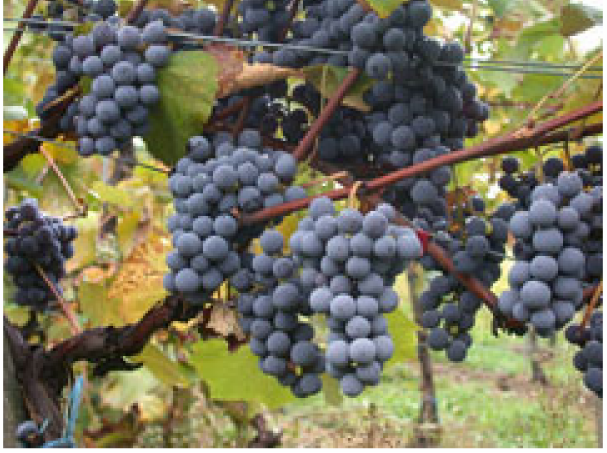
Figure 9. Vitis vinifera L.